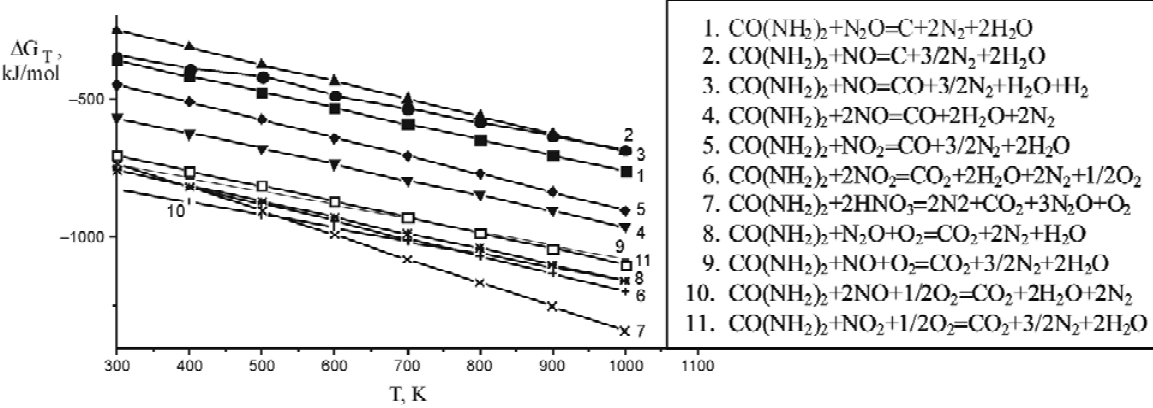
Fig. 1. The Gibbs’ energy value changes dependency on temperature while carbamide reduces nitrogen